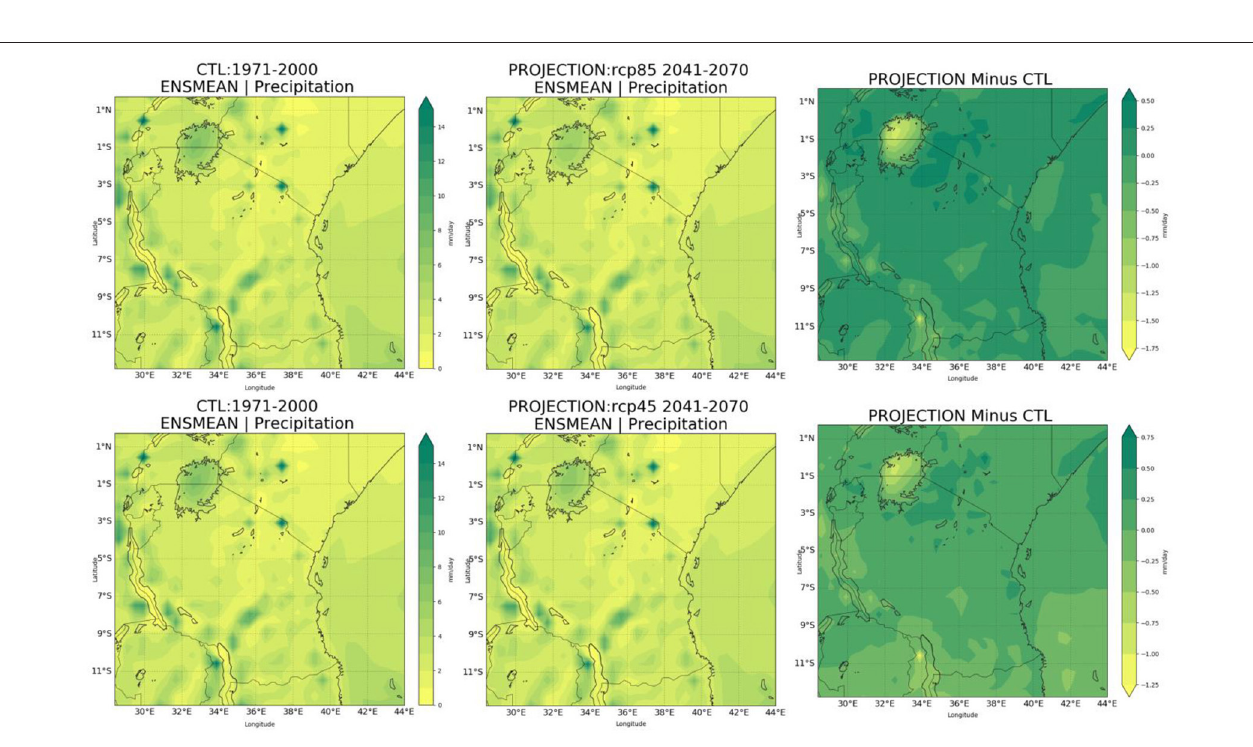
Frontiers in Environmental Science |